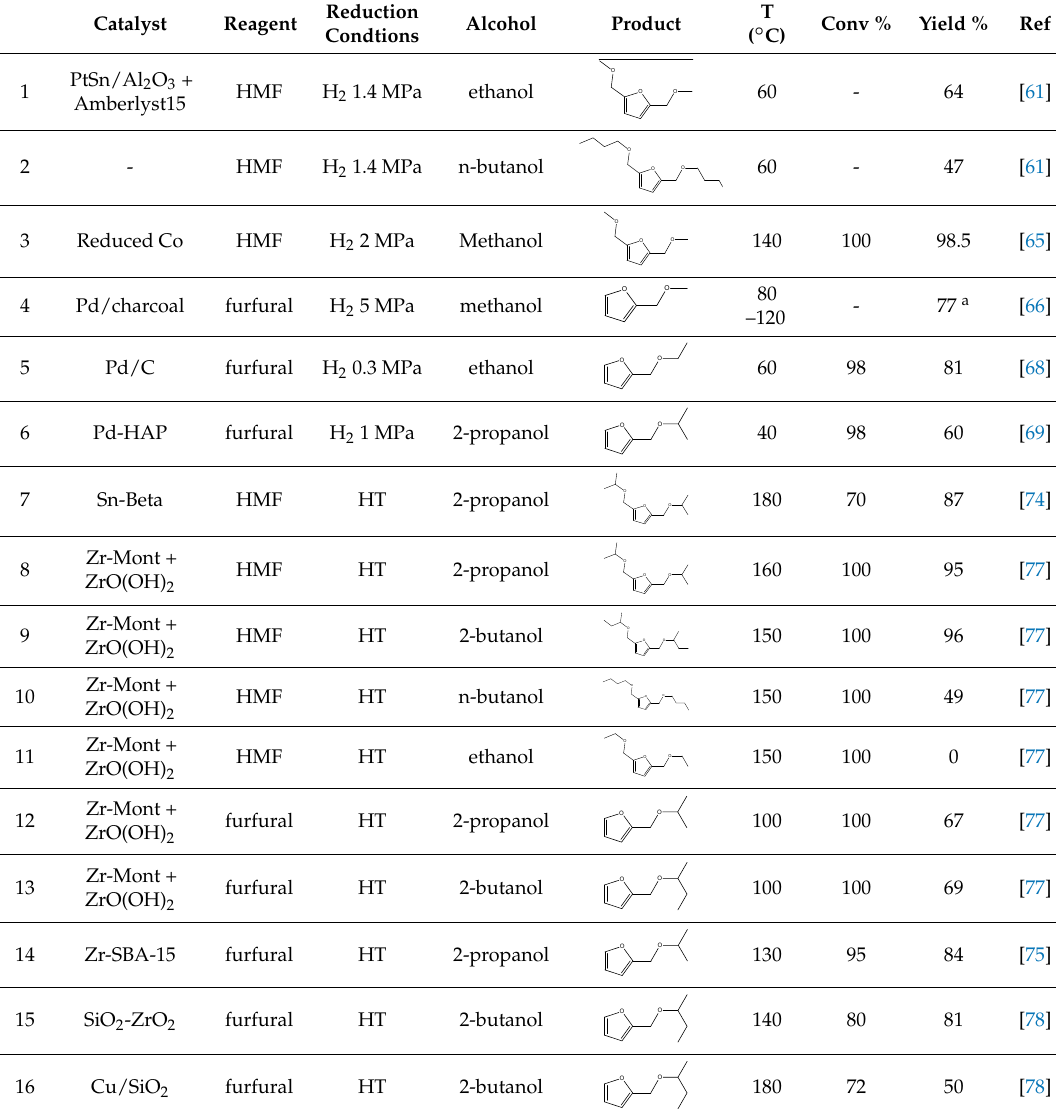
Table 4. Comparison of catalytic procedures for furanic ethers by the cascade process starting from furfural or HMF.